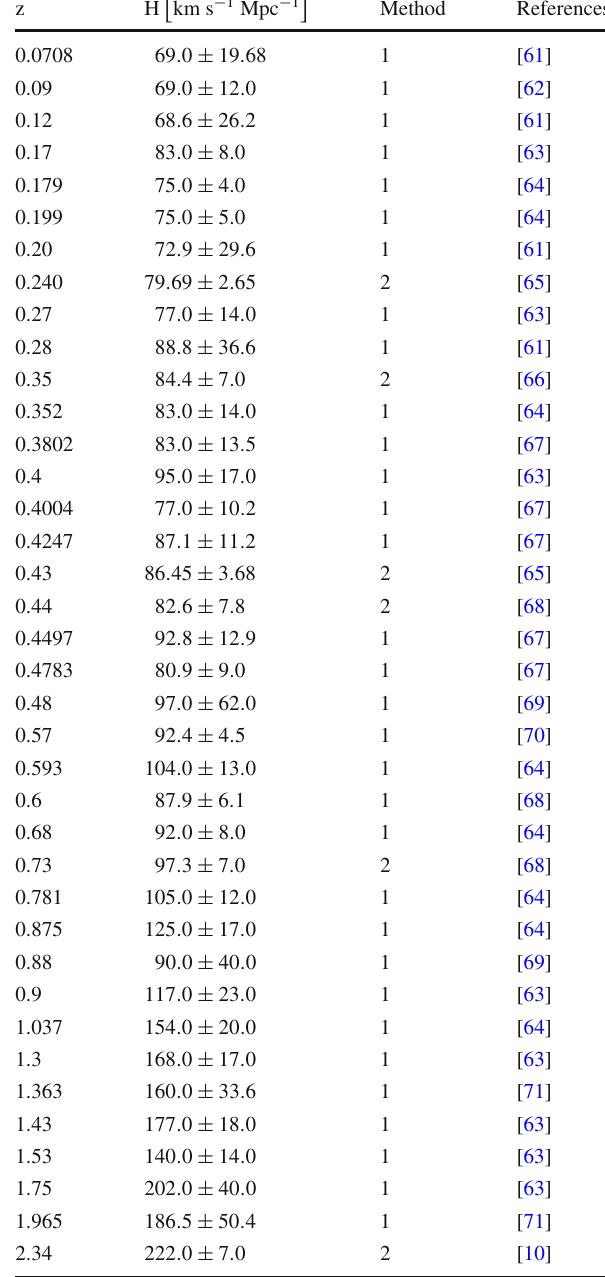
Table 1 OHD from galactic surveys. There are two methods used. In the below table, “1” represents the differential galaxies age method, and “2” represents the radial BAO size